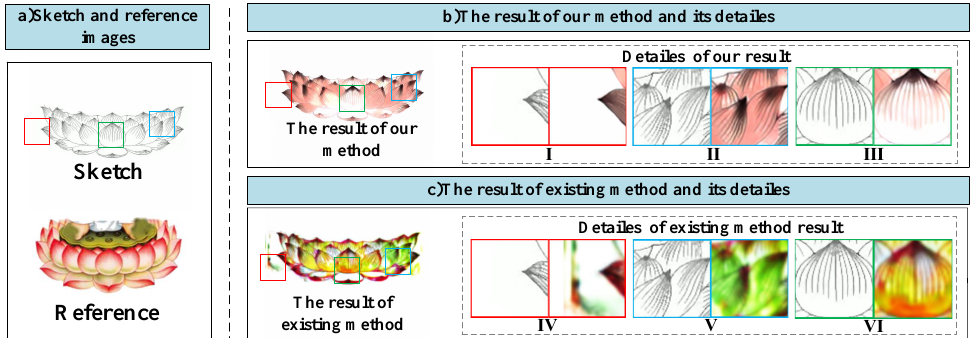
Figure 1. The proposed MACF-SCA obtains the best colorization map with more accurate colors and better visual effects ( b ). Existing reference-based methods cannot accurately migrate the color semantic information ( c ). The detailed parts show that our model can accurately distinguish the semantic information of dense lines ( I , II , III ), and the existing model shows obvious visual artifacts, color confusion and color errors ( IV , V , VI